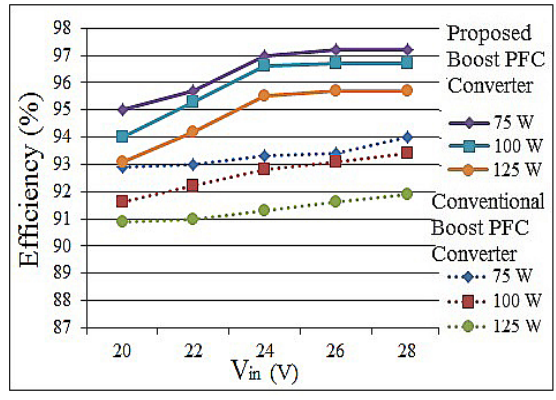
Figure 7. Input voltage and efficiency.